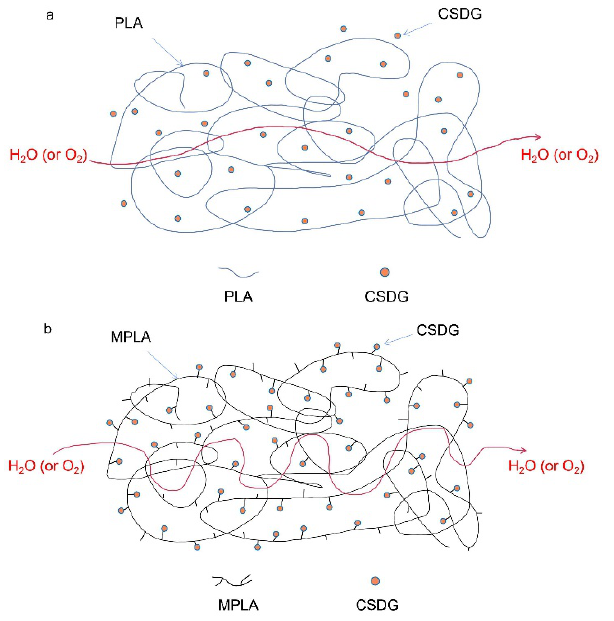
Figure 11. Schematic of molecular permeation path for water vapor or oxygen: ( a ) PLA/CSDG; ( b ) MPLA/CSDG.